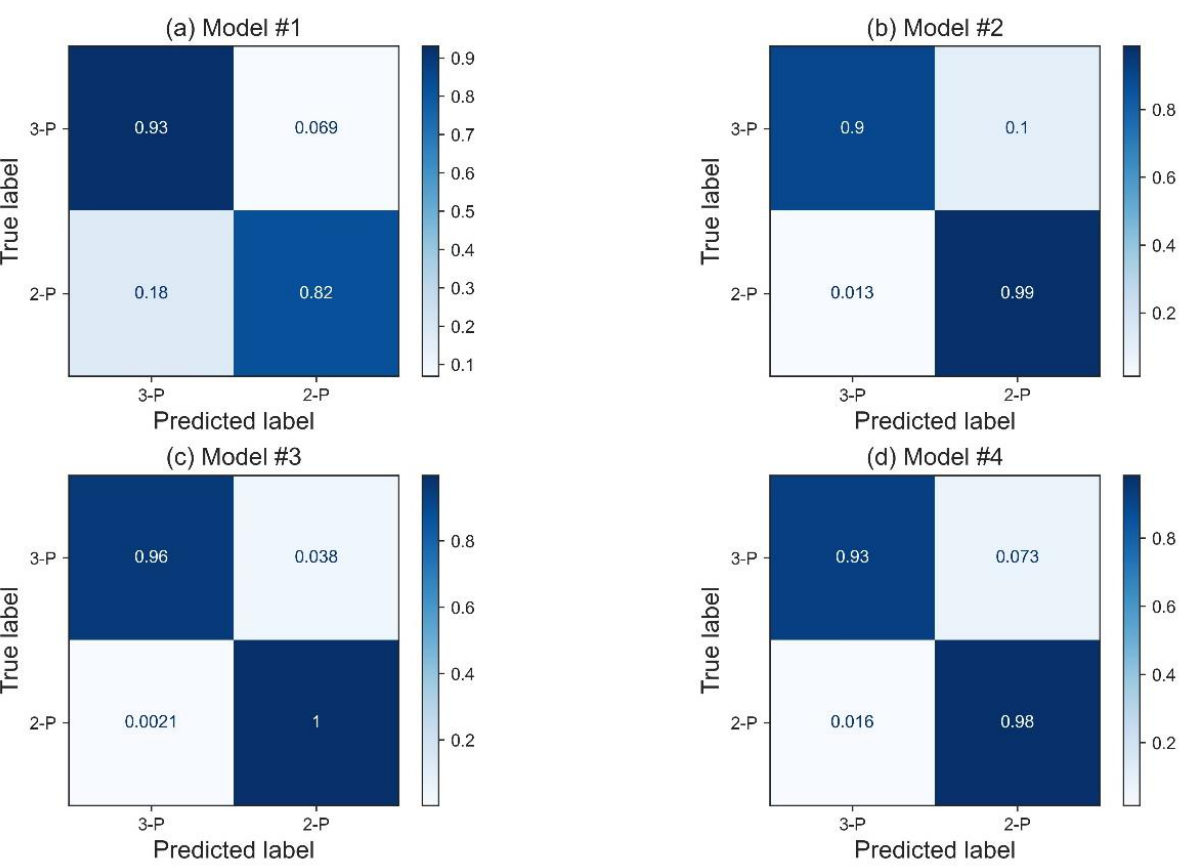
Figure 17. Confusion Matrix for the Tested Classification Models using Strategy 1.